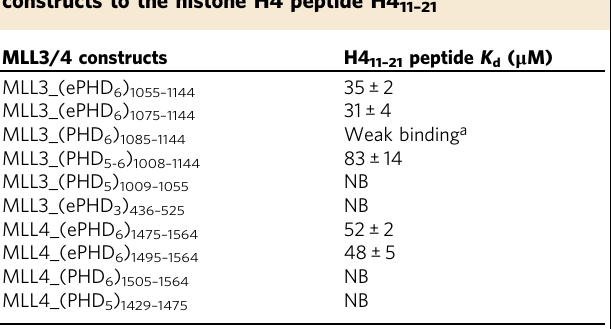
Table 2 Binding af fi nities of different MLL3 or MLL4 constructs to the histone H4 peptide H4 11 – 21